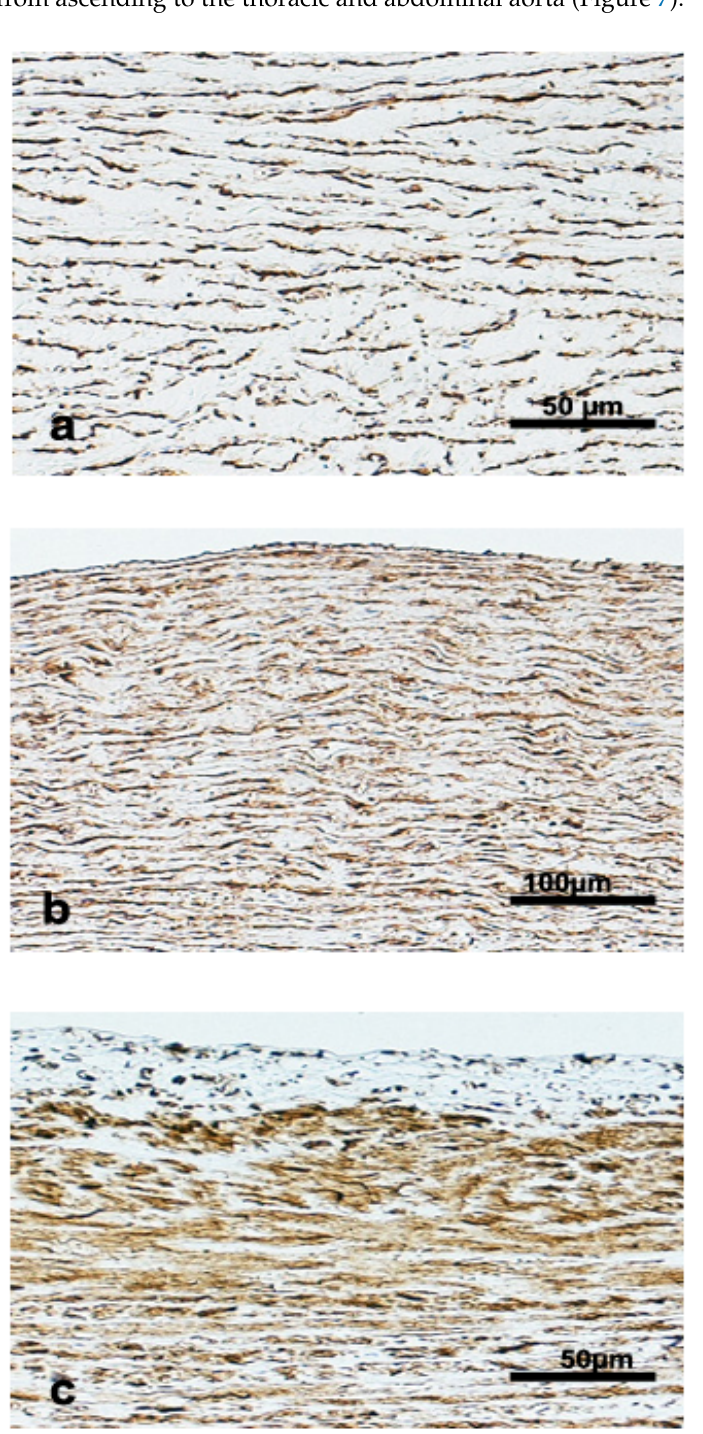
Figure 7. Alfa- actin immunodetection in the ( a ) ascending aorta of a juvenile male Kogia breviceps , ( b ) thoracic aorta of an adult male Globicephala macrorhynchus , ( c ) abdominal aorta of an adult female Mesoplodon densirostris . Brown staining indicates the presence of smcs in the aortic wall.